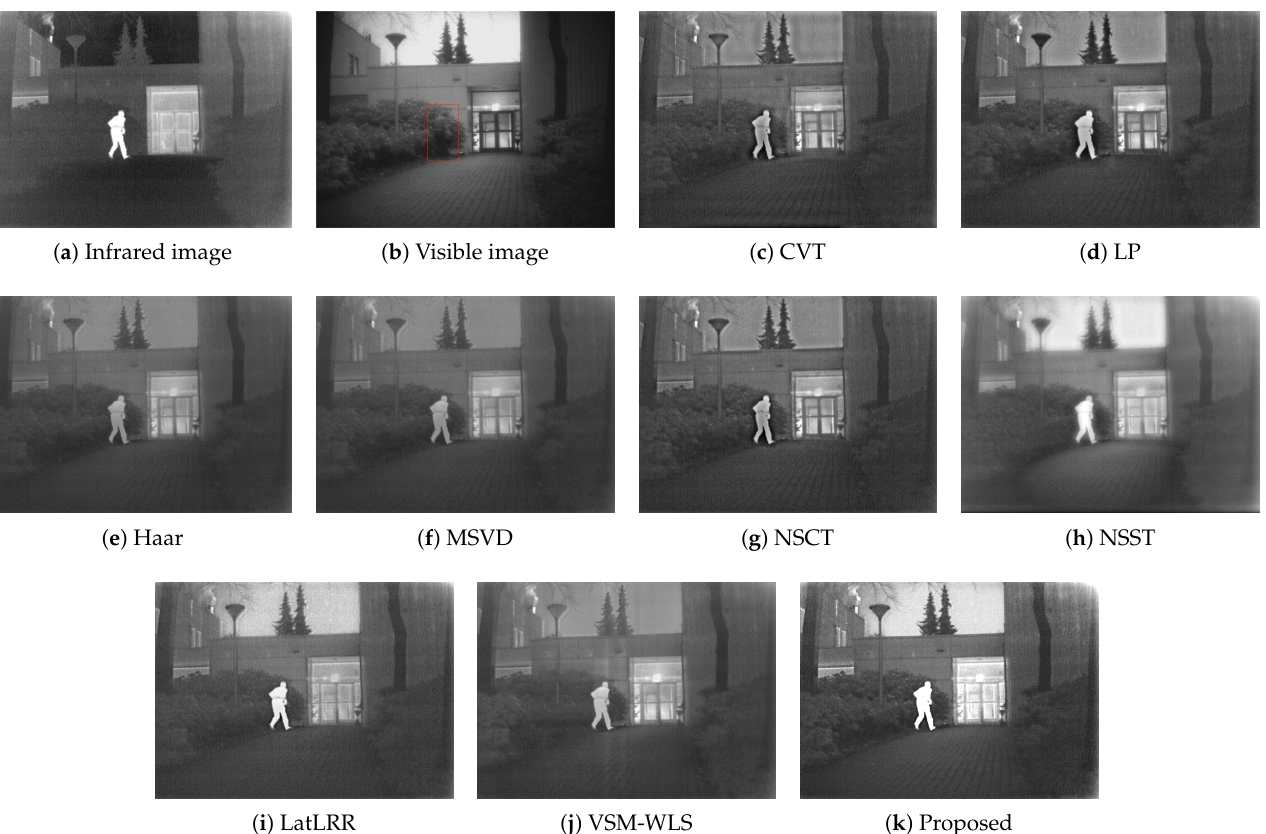
Figure 9. Image fusion results of the second group. The red box part is the location of the person in the visible image.